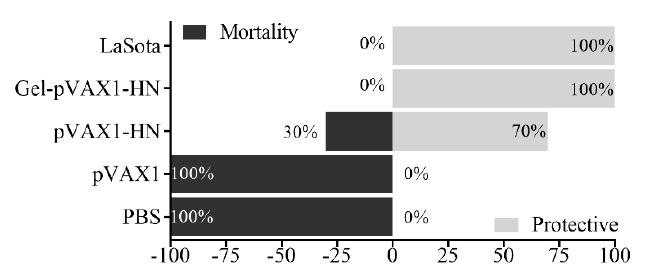
Figure 7. Protective efficacy of the immunized chickens against the highly virulent NDV strain. Chickens in all groups (n = 10) were challenged with the highly virulent NDV strain; after 14 days, the protection and mortality rates were recorded.